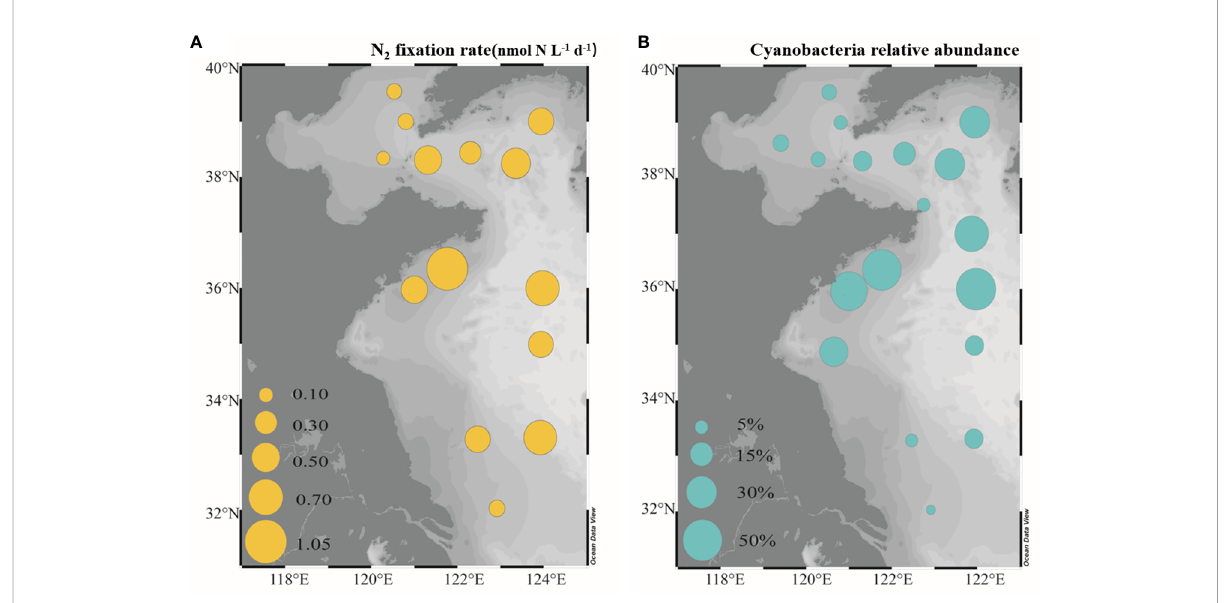
FIGURE 5 Distribution of N 2 fi xation rates (A) and the relative abundance of cyanobacteria (B) in surface seawaters of the BS and